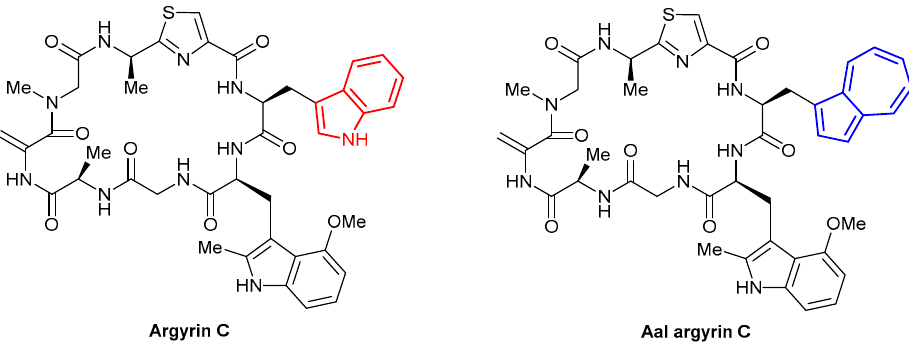
Figure 15. Argyrin C and Aal argyrin C synthesised by Kalesse et al . [81] . Azulenyl squaraines have found use in biological settings as NIR FRET